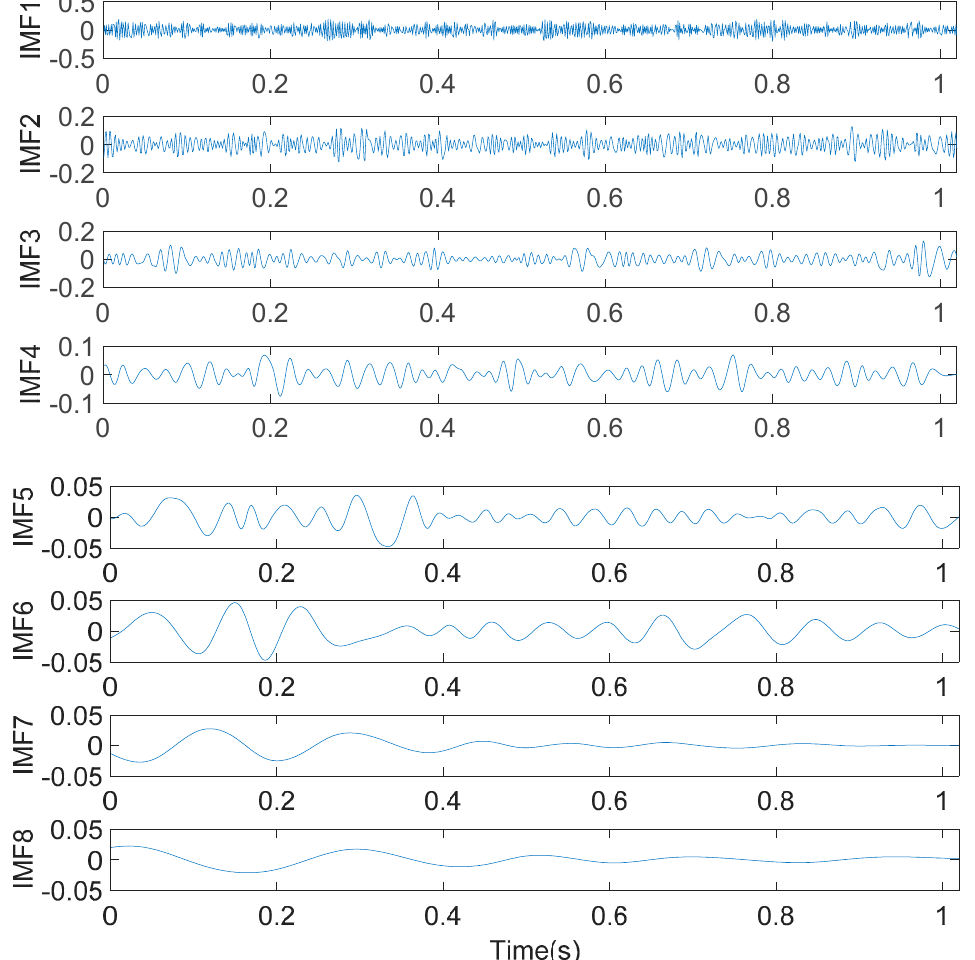
Figure 6. Time-domain waveform of the IMF1 component.